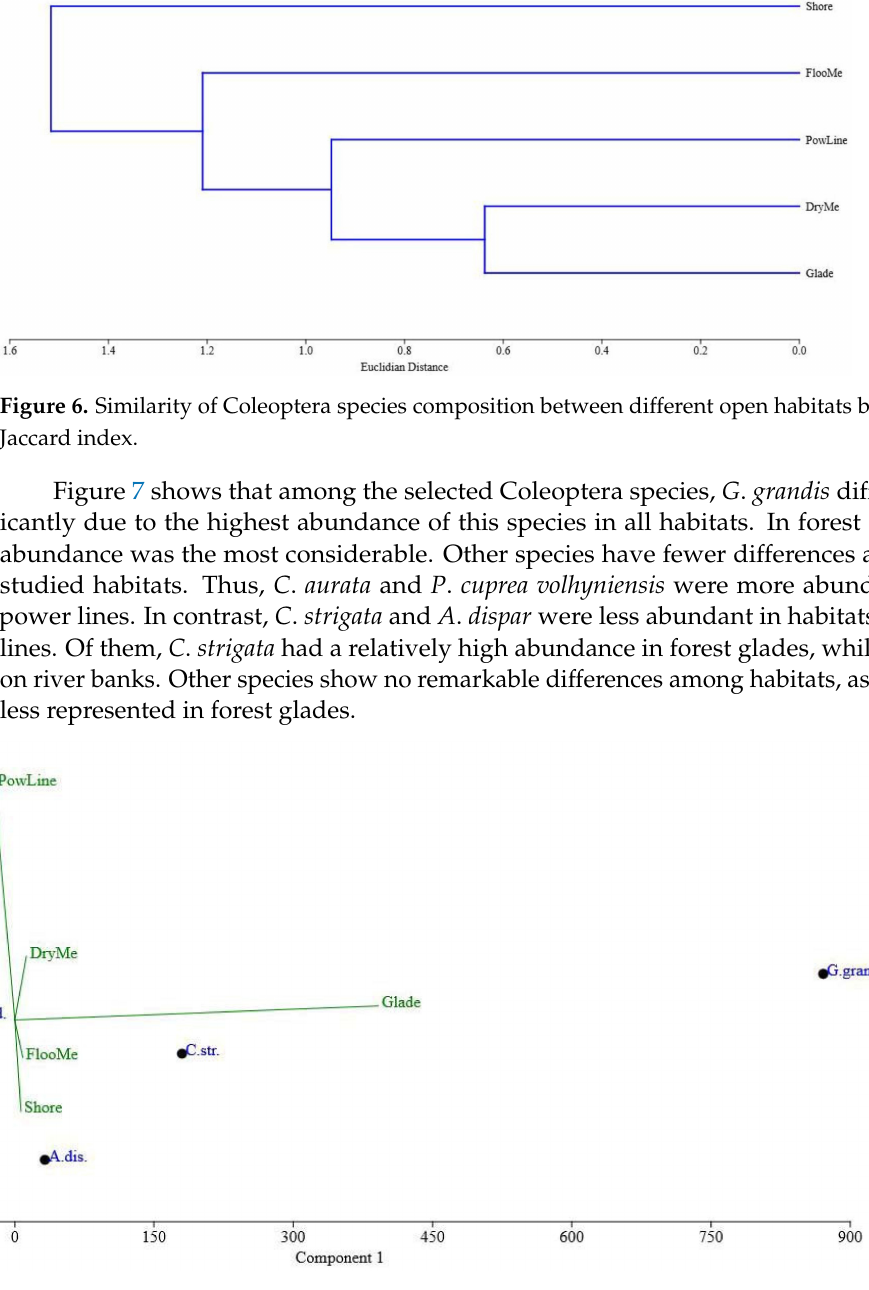
Figure 7. Principal component analysis (PCA) ordination diagram of the selected Coleoptera species based on their abundance in the studied habitats. Species: C.aur.— Cetonia aurata (Scarabaeidae), A.mur.— Agrypnus murinus (Elateridae), P.mar.— Protaetia marmorata (Scarabaeidae), P.c.vol.— Protaetia cuprea volhyniensis (Scarabaeidae), P.tes.— Prosternon tessellatum (Elateridae), C.str.— Cryptarcha stri- gata (Nitidulidae), G.gran.— Glischrochilus grandis (Nitidulidae), G.hor.— Glischrochilus hortensis (Nitidulidae), S.gris.— Soronia grisea (Nitidulidae), Ch.vir.— Chrysanthia viridissima (Oedemeridae), L.quad.— Leptura quadrifasciata (Cerambycidae), A.dis.— Anisandrus dispar